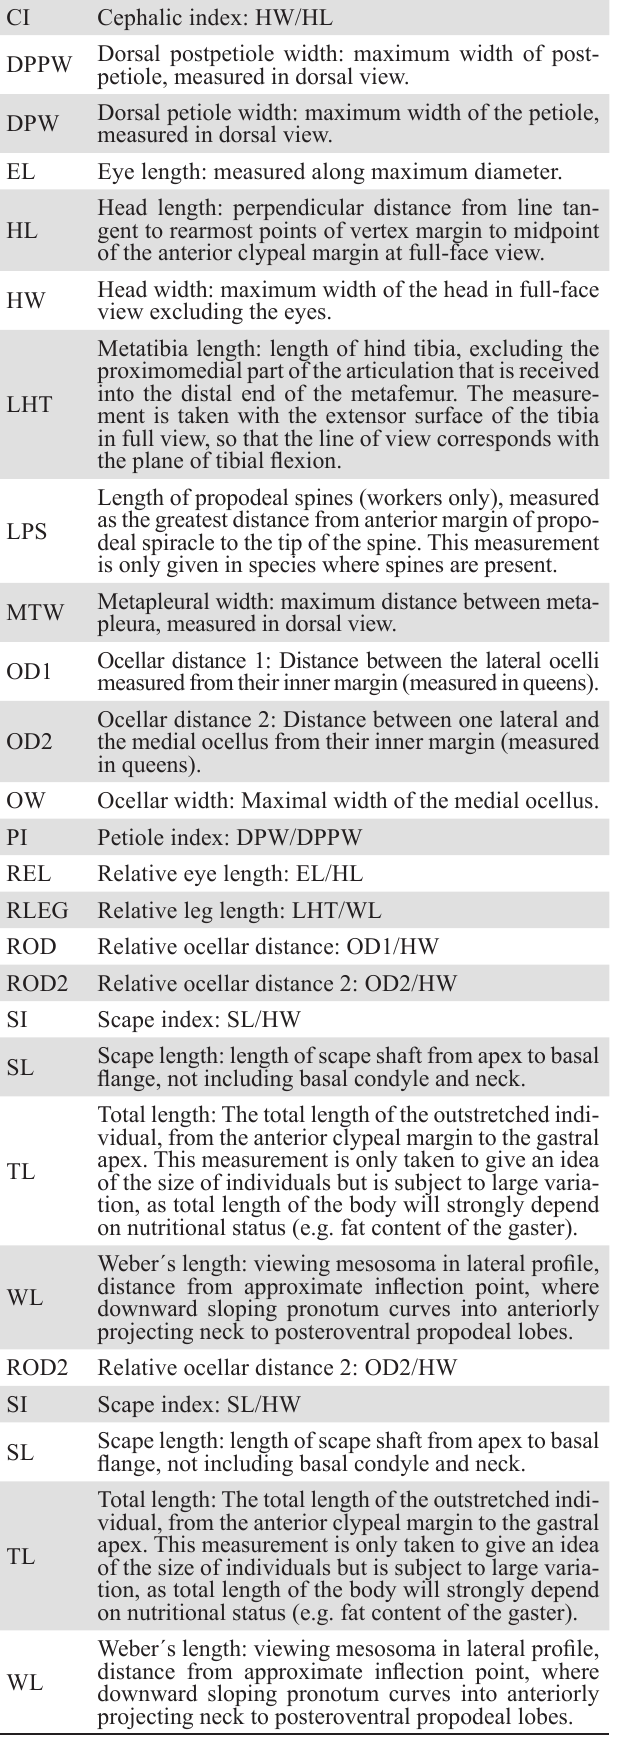
Weber´s length: viewing mesosoma in lateral profile, distance from approximate inflection point, where downward sloping pronotum curves into anteriorly projecting neck to posteroventral propodeal